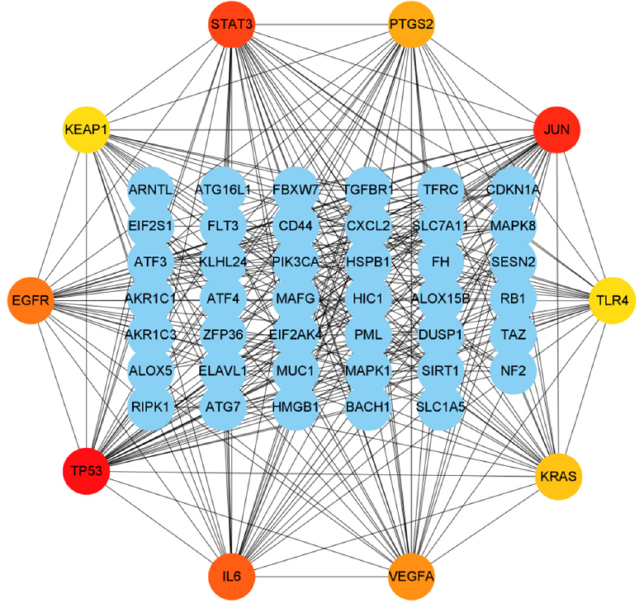
Figure 6. PPI network created using additional DEGs and 10 hub genes. The weight of a hub gene across the network increases with the hue of the gene.